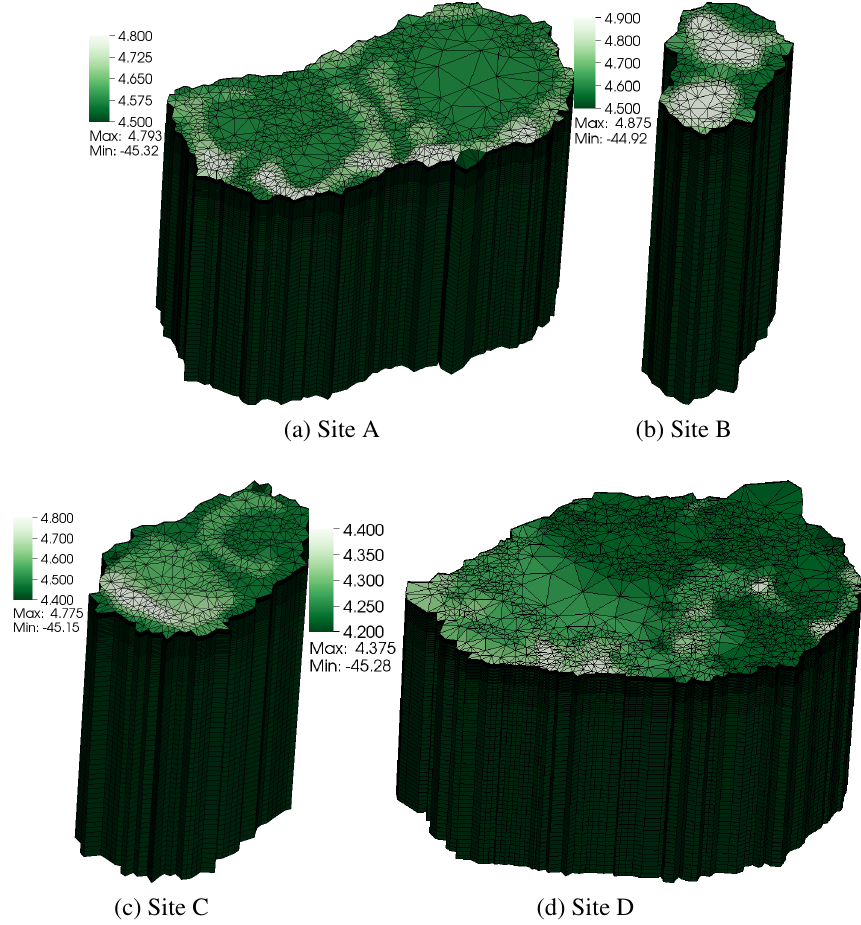
Figure 5. Microtopography resolving unstructured meshes. The coloring reflects the ground surface elevation. Variable resolution mesh adapts to complex topography and uses finer resolution in areas of strong relief and coarser resolution in simpler terrain.